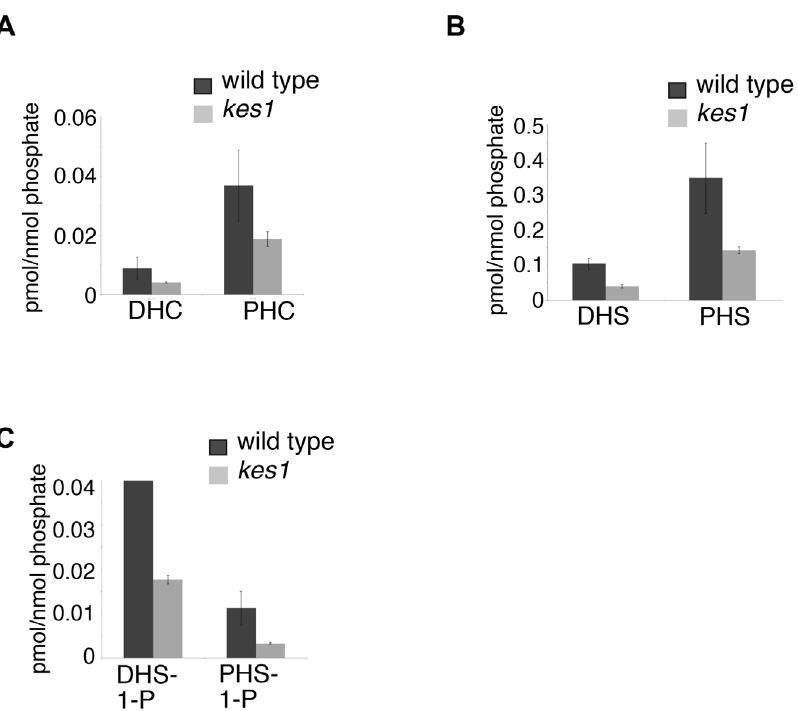
Figure 2. Kes1 affects sphingoid base and ceramide levels. Sphingolipids were extracted and measured by liquid chromatography-mass spectrometry and normalized to total inorganic phosphate. Total lipid levels representing all chain lengths are given for (A) dihydroceramide (DHC) and phytoceramide (PHC), (B) dihydrosphingosine (DHS) and phytosphingosine (PHS) and (C) dihydrosphingosine-1-phosphate (DHS-1-P) and phytosphingosine-1-phosphate (PHS-1-P). Data are expressed as a mean + / 2 SE of a minimum of three separate